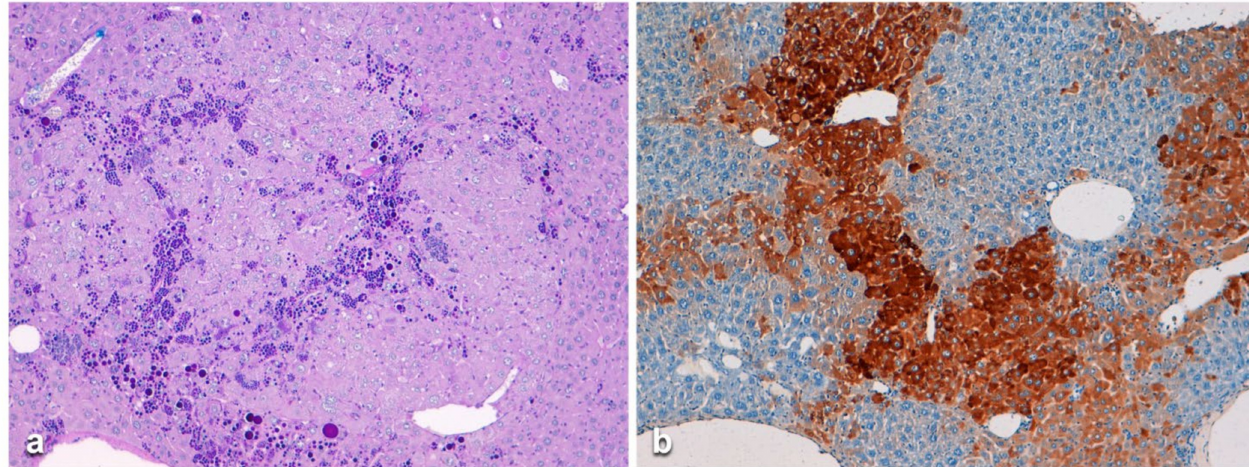
Figure 19. Histological section from a Pi Z mouse liver. The low power view shows preserved lobular architecture in the absence of inflammation or necrosis. Periportal hepatocytes contain PASD globules similar to human Pi Z individuals ( a ) (PASD × 2). The immunostaining for AAT highlights the topographical distribution and the morphology of the globules corresponding to the PASD stain ( b ) (AAT immunostaining ×